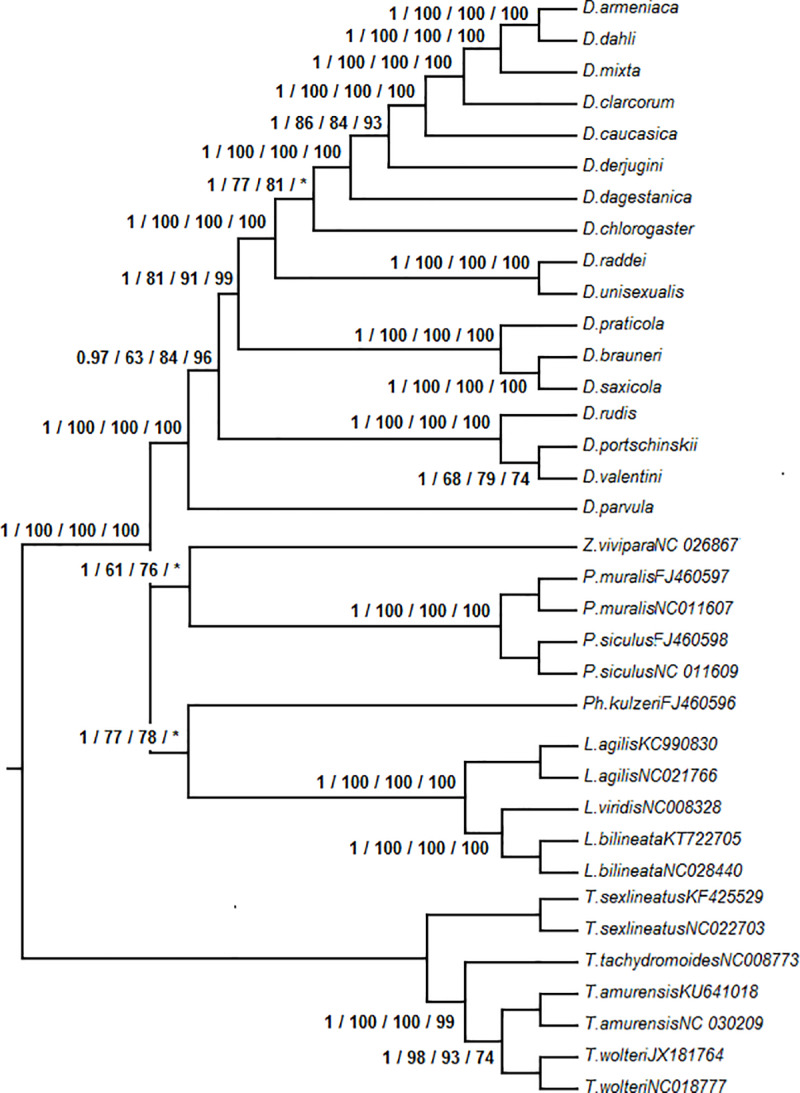
Strict consensus phylogenetic tree of Lacertini, based on the four applied methods, rooted at midpoint.The tree is based on the complete mitochondrial genome with the excluded control region and genes ATP8, ND2, ND3, and ND1. Posterior probabilities (BI) and bootstrap supports (ML / NJ / MP) left to the nodes. *—bootstrap support below 50. The politomy reflects the disagreement between the BI and MP, on one side, and ML and NJ methods.